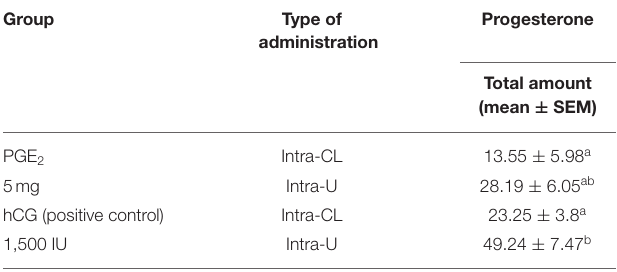
All values are expressed as total amount of PGE 2 secretion (area under curve). Different superscript letters a , b indicate significant differences in PGE 2 concentration between PGE 2 and hCG groups. The results were considered significantly different at p <